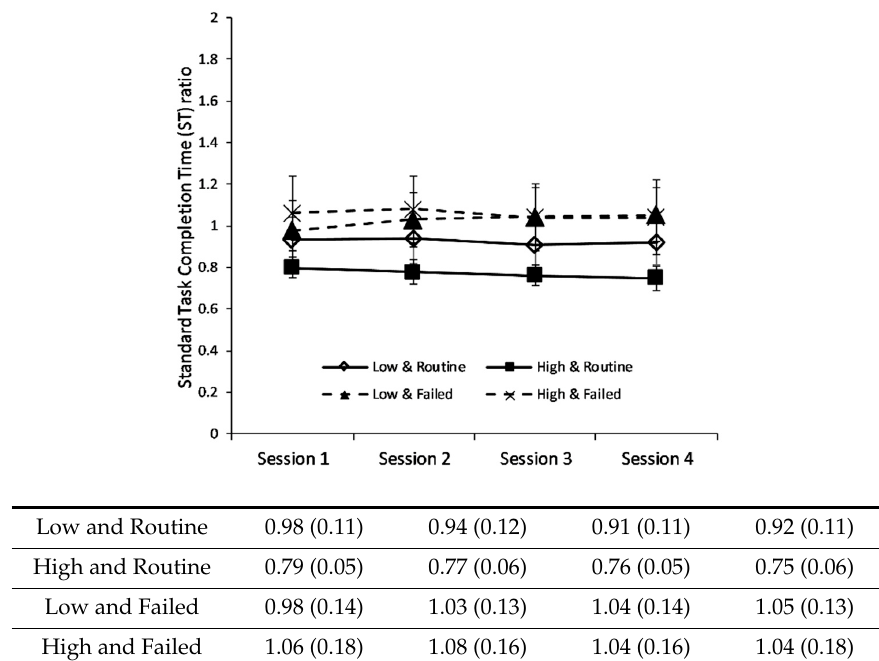
Figure 4. Variations in longitudinal ST ratios in the four sessions.